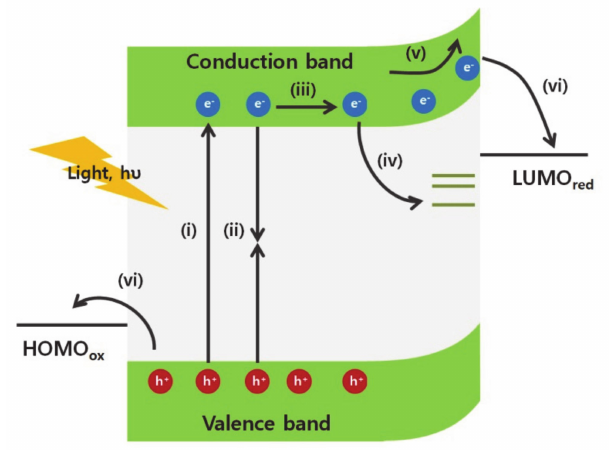
Figure 1. Illustration of photogenerated charge carriers dynamics in photocathodic catalysts (i) excitation of electrons and holes by absorption of light above band gap of semiconductors, (ii) radiative recombination, (iii) di ff usion of charge carriers, (iv) charge carriers trapped in the surface defect states, (v) drifted flow of electrons induced by band bending on the surface, and (vi) charge separation into the electron / hole acceptors at the interface and chemical reaction of electron / hole